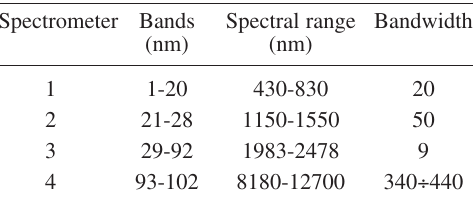
Table I. MIVIS spectral characteristics. Spectrometer Bands